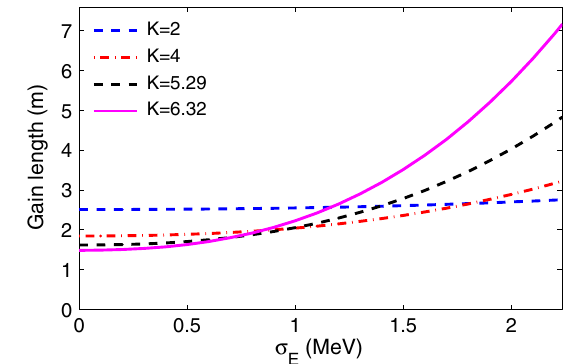
FIG. 3. Power gain length at (cid:2) 0 ¼ 0 : 6 nm as a function of beam energy spread with LCLS-II parameters for various lasing scenarios: fundamental lasing with K ¼ 2 , 3rd harmonic lasing with K ¼ 4 , 5th harmonic lasing with K ¼ 5 : 29 , and 7th har- monic lasing with K ¼ 6 : 32